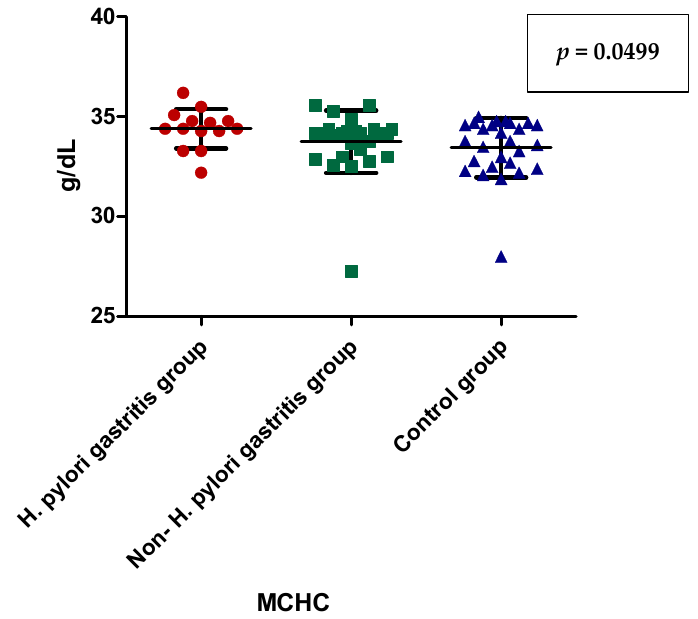
Figure 2. The difference of median values of MCHC between the three groups. Likewise, we did not obtain any significant differences between the median values of neutrophils among the three groups, but we proved that children with H. pylori -induced gastritis had significantly higher values when compared to non- H. pylori gastritis group ( p = 0.0146) (Table 5 and Figure